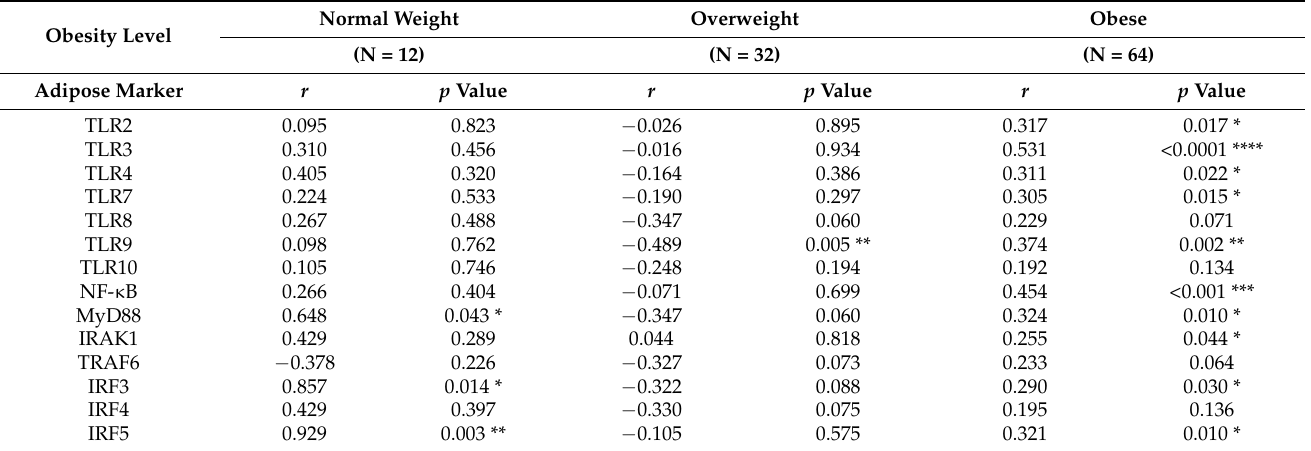
Table 3. Spearman´s correlation analysis of adipose gene expression of SRA1 with TLRs, their signaling mediators, and IRFs in individuals differing by obesity levels.